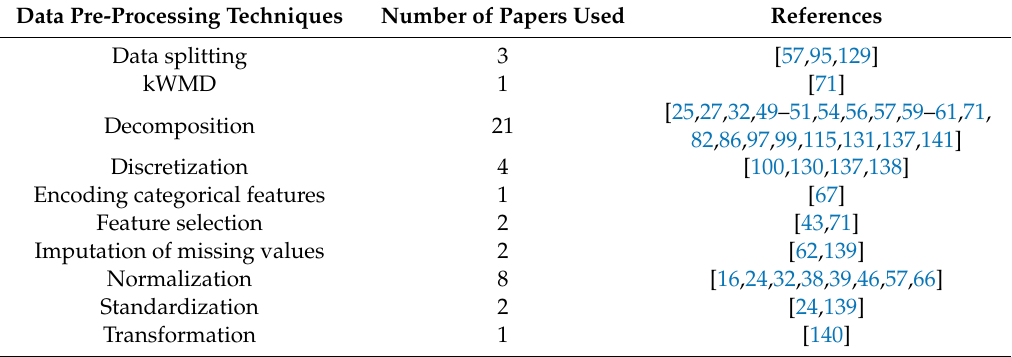
Table 3. Pre-processing techniques used by machine-learning models for renewable-energy predictions.